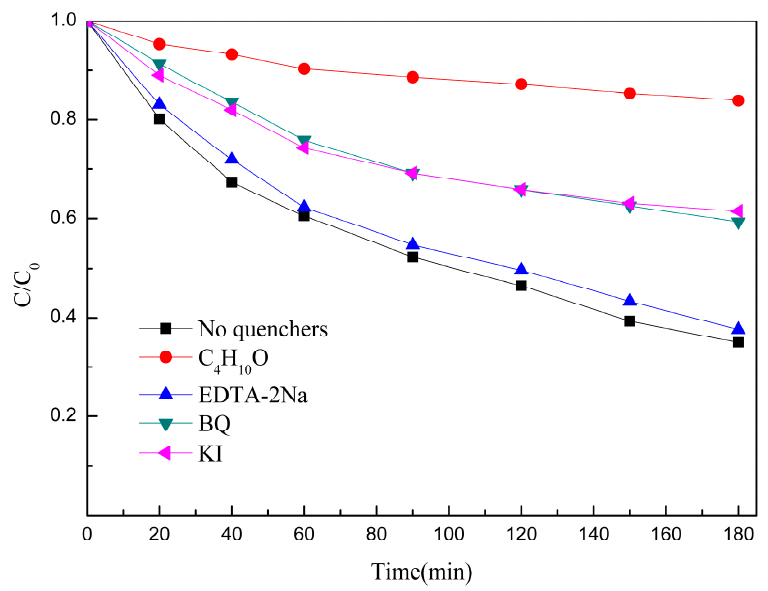
Figure 10. Effects of different group capture factors on COD removal of pharmaceutical wastewater.